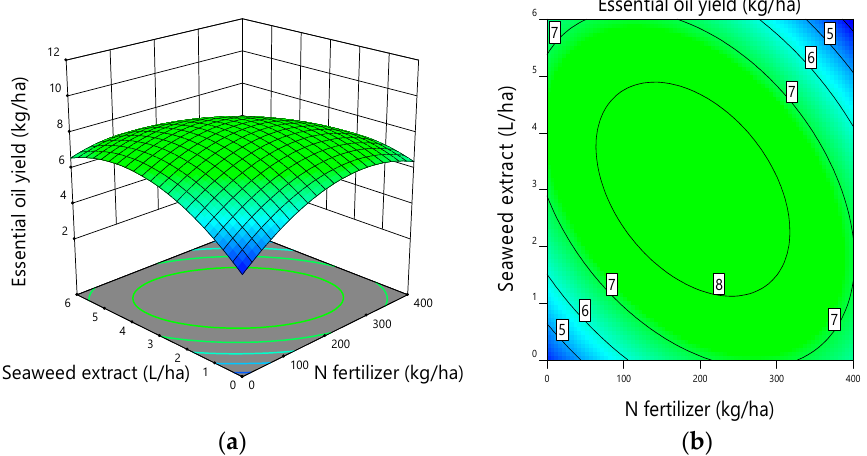
Figure 5. Response surface ( a ), and contour plot ( b ) showing the interactive effects of N and K fertilizers on the essential oil yield of thyme. Seaweed extract was kept constant at 3 L ha − 1 . The response surface and contour plot of EO yield as affected by interaction of nitrogen and seaweed extract (Figure 6) clearly followed a quadratic trend and reached its peak value when intermediate rates of N and seaweed extract were used.